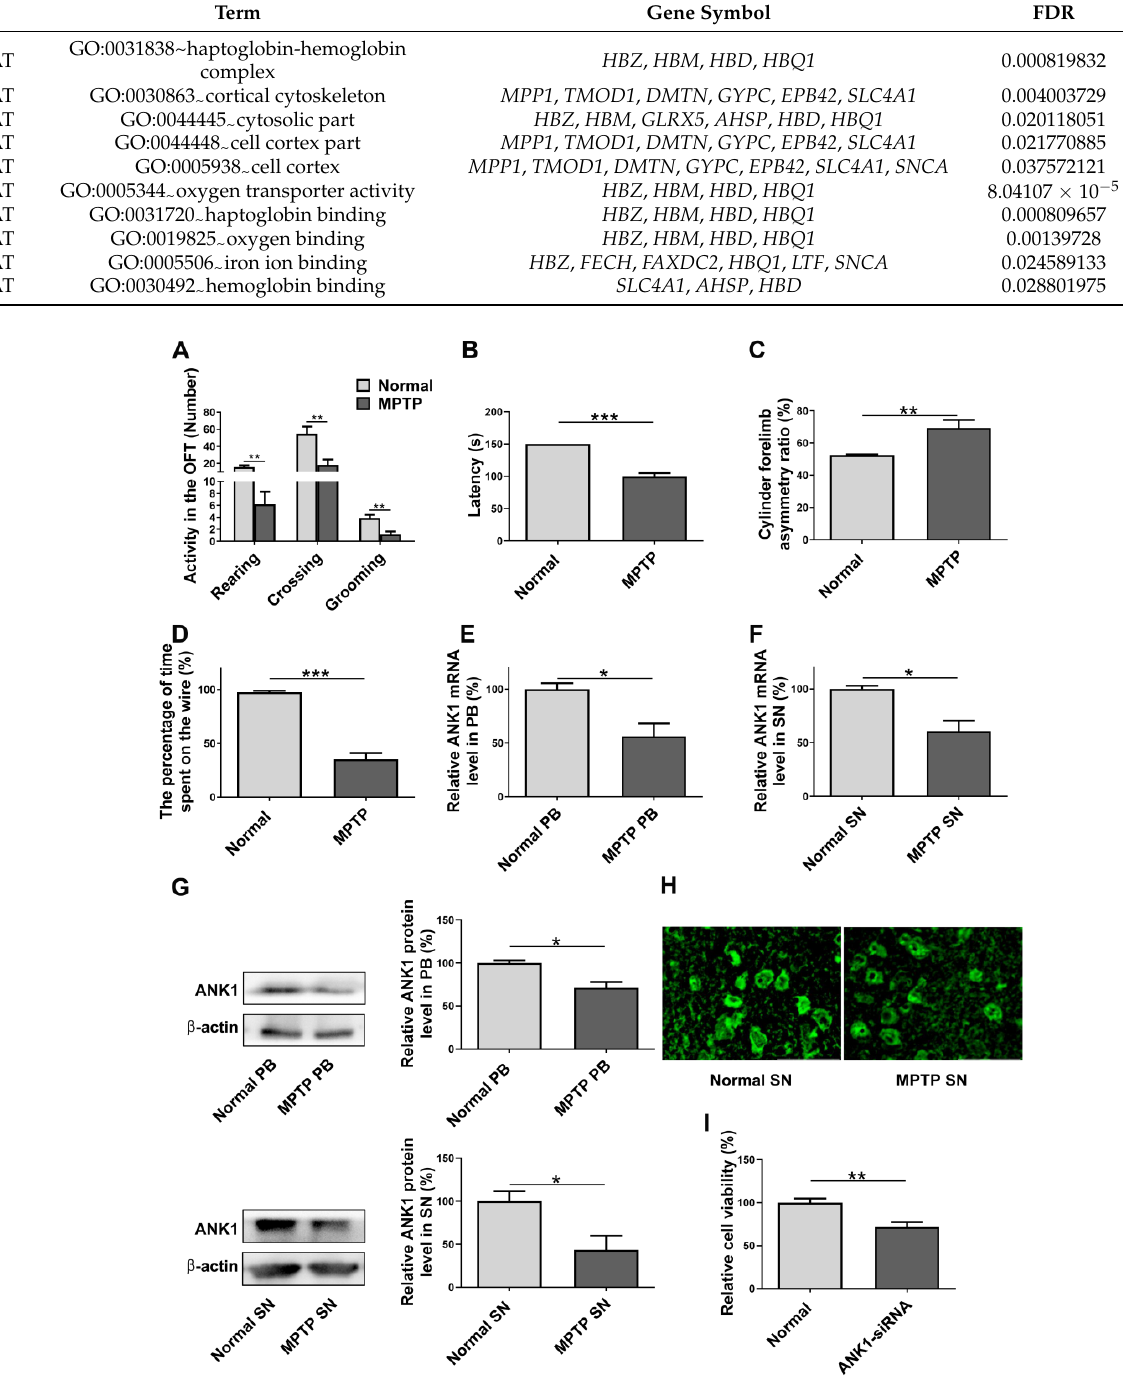
Figure 5. Validation of ANK1 using in vivo and in vitro models. ( A ) The open-field experiment was achieved to test the mice’s spontaneous activity. ( B ) The rotarod test was carried out to estimate the motor balance. ( C ) The cylinder test was performed to appraise forelimb placement. ( D ) The suspension test was employed to measure muscle strength. ( E ) ANK1 mRNA level in blood was measured by quantitative PCR. ( F ) ANK1 mRNA level in SN was measured by quantitative PCR. ( G ) ANK1 protein expression was measured by Western blot. ( H ) Immunofluorescence of SN ANK1. ( I ) Cell viability analysis was performed by MTT analysis. Data are expressed as mean ± S.E.M. Two groups were analyzed using Student ’ s t-test. * p < 0.05, ** p < 0.01, *** p < 0.001.